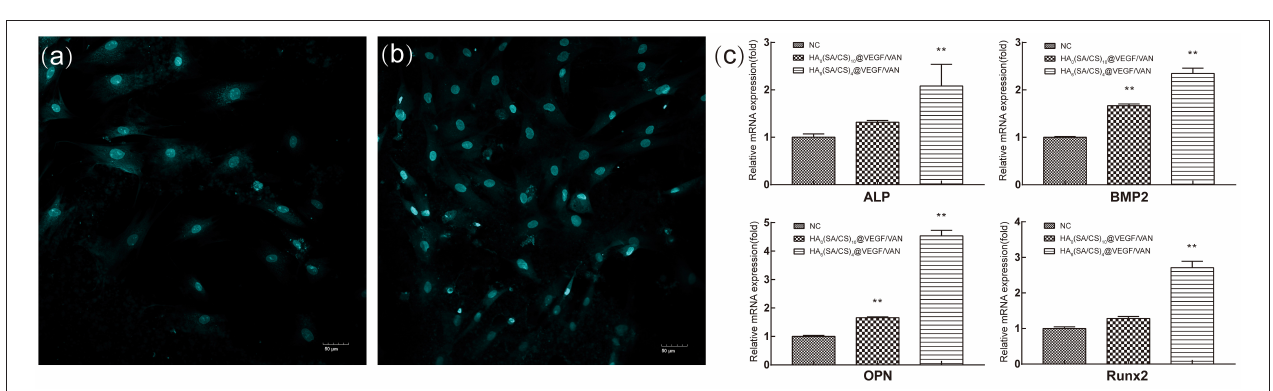
FIGURE 9 | (a) Laser confocal image of cells adhesion on HA 0 (SA/CS) 10 @VEGF/VAN scaffold. (b) Laser confocal image of cells adhesion on. (c) Real-time PCR results of osteogenesis-related gene in each group. ** p < 0.01.